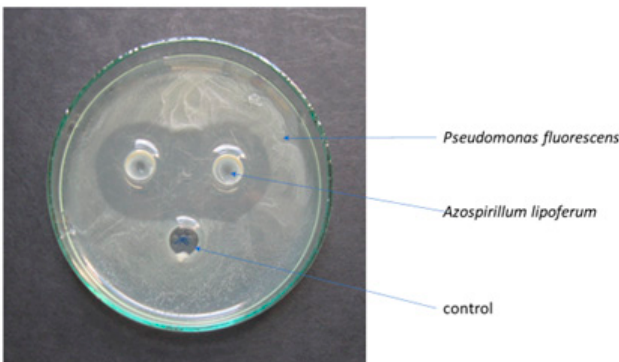
Figure 1. Antagonistic interaction between Azospirillum lipoferum Br17 and Pseudomonas fluorescens.